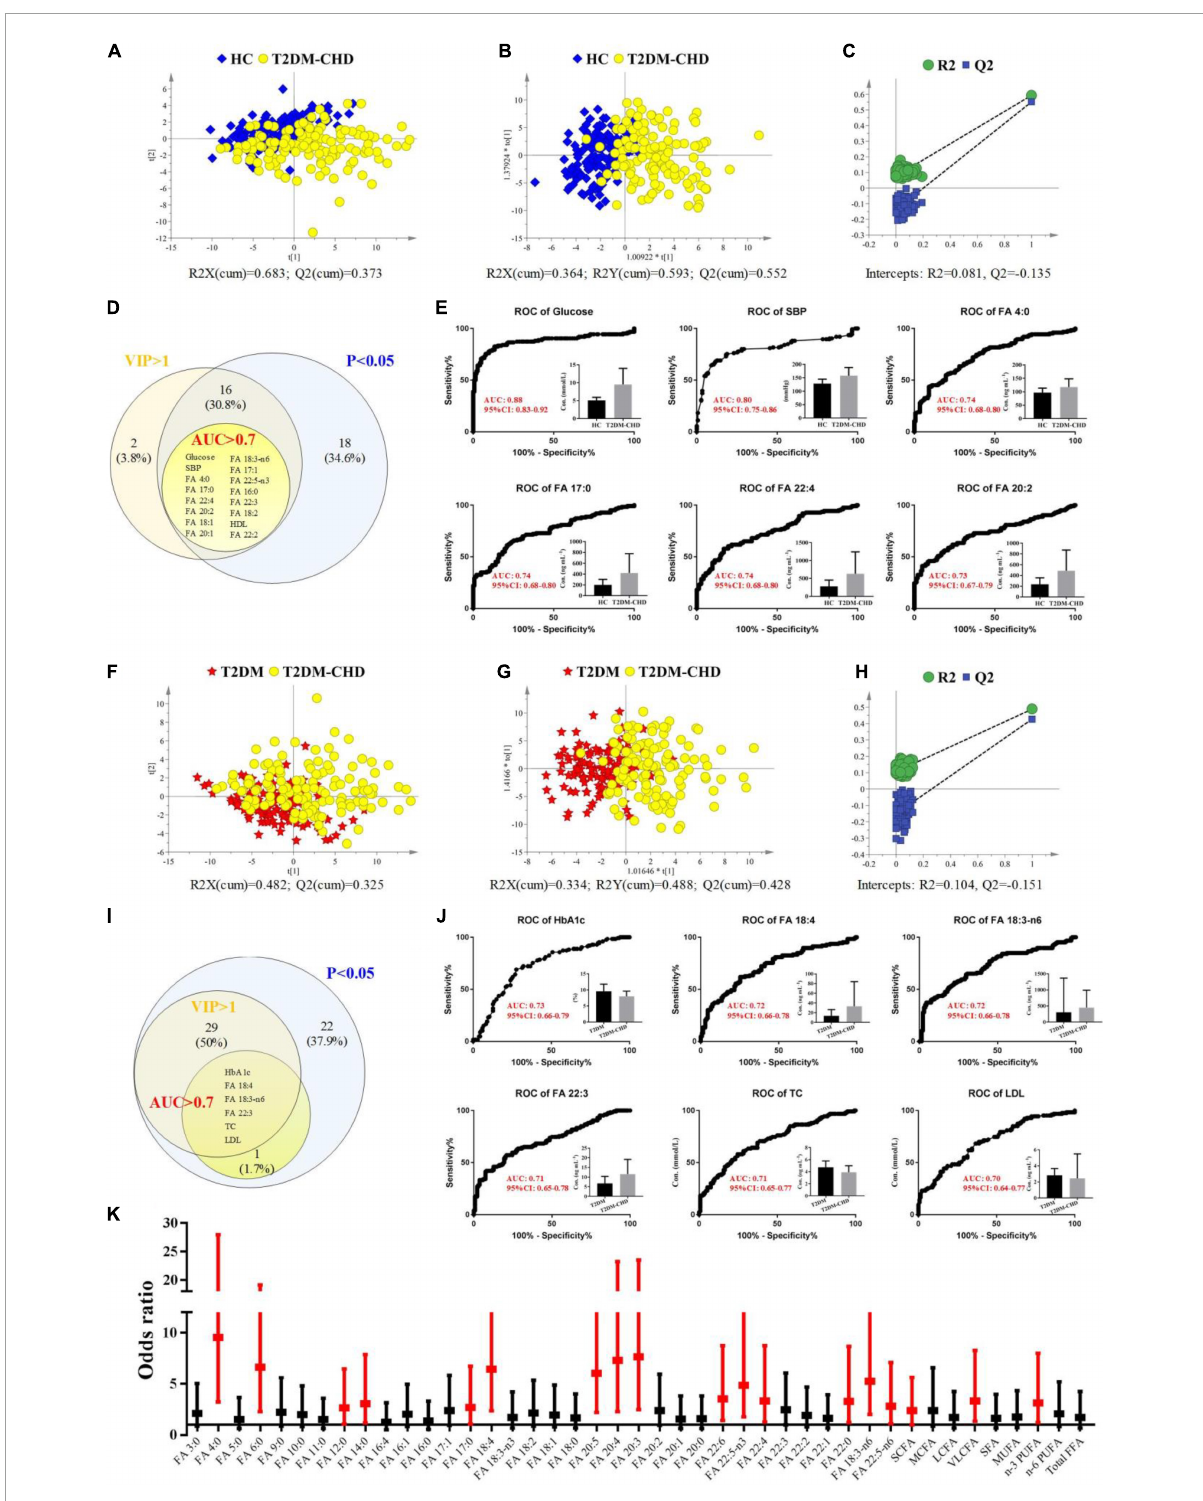
FIGURE4 (A–E) Exploration of differences between HC and T2DM-CHD groups. (A) PCA score scatter plot. (B) OPLS-DA score scatter plot. (C) Random permutation test of the OPLS-DA model. (D) Venn diagram depicting the overlap of different statistical methods. (E) ROC curves of the potential biomarkers for the discrimination of HC and T2DM-CHD groups. (F–J) Exploration of differences between T2DM and T2DM-CHD groups. (F) PCA score scatter plot. (G) OPLS-DA score scatter plot. (H) Random permutation test of the OPLS-DA model. (I) Venn diagram depicting the overlap of different statistical methods. (J) ROC curves of the potential biomarkers for the discrimination of T2DM and T2DM-CHD groups. (K) A forest plot of the significantly changed FFAs between T2DM and T2DM-CHD groups. Red indicates FFAs with P < 0.05 in multivariate